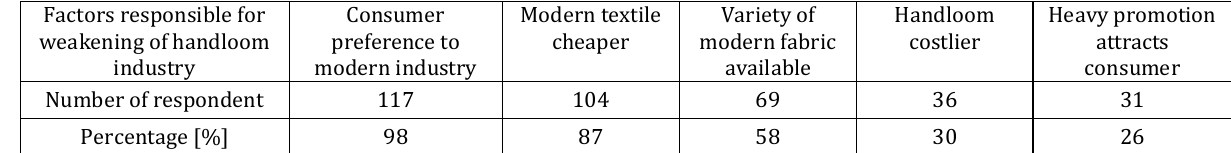
Table 4. Table showing factors responsible for weakening of handloom industry (n=120) (Source: Primary survey 2017–2018) Factors responsible for